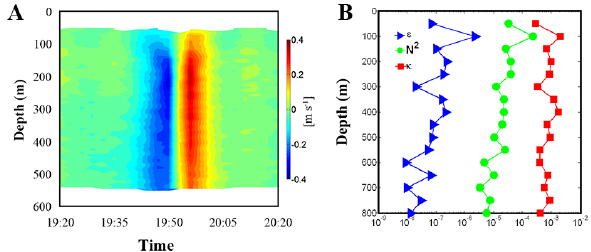
Fig. 5. Physical transportation mechanisms of Prochlorococcus in the Luzon Strait. (A) A case (31 March 2010) of the 384 soli- tons observed from 21 March 2010 to 20 April 2011 at 21 ◦ 00 0 N, 119 ◦ 00 0 E, showing the distribution of the vertical movement. (B) A case (28 March 2010) of the observed water column mixing at 21 ◦ 02 0 N, 119 ◦ 21 0 E. ε indicates the dissipation rate of turbulent ki- netic energy (Wkg − 1 ), N 2 the buoyancy frequency square (s − 2 ) , and κ the mixing rate (m 2 s − 1 , at around 10 − 3 m 2 s − 1 , 100-fold the oceanic background